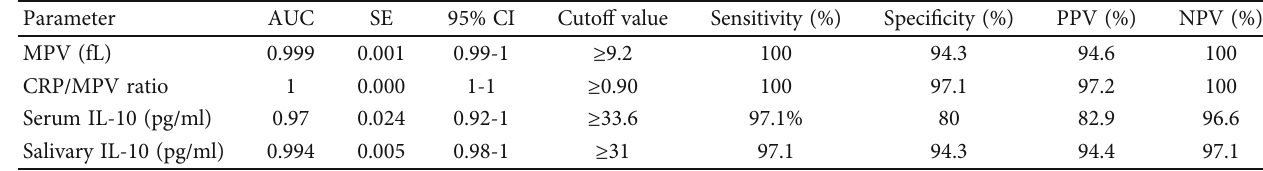
Table 3: ROC curves for salivary and serum IL-10, MPV, and CRP/MPV ratio to predict late-onset sepsis.